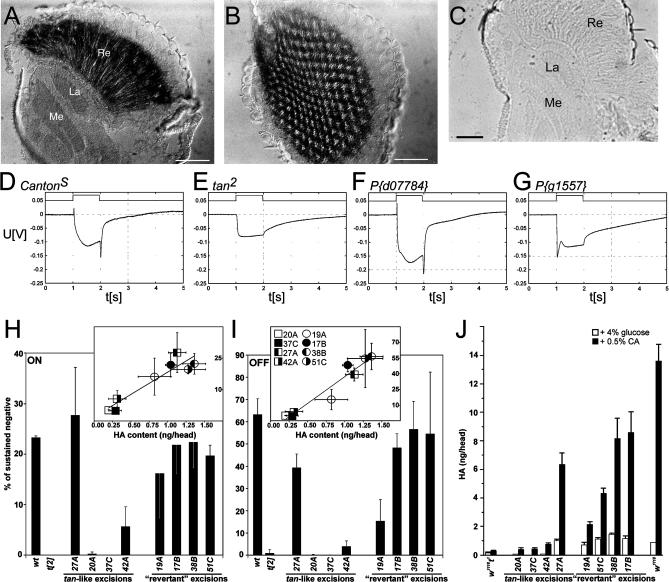
Tan Expression and Function in the Eye and Optic Lobes(A) RNA in situ hybridization with an antisense tan cDNA probe to wild-type adult head sections. Horizontal section cut through the eye and the optic lobes.(B) Sagittal section through the ommatidial array of the eye.(C) Control sense probe does not show significant staining (horizontal section).(D–G) ERG phenotypes of wild-type flies (D) and tan mutants (E–G). (D) CantonS (wild-type) ERG showing normal “on” and “off” transients. Upper trace in each recording indicates duration of light input stimulus (see Materials and Methods). (E) tan2 mutant showing complete absence of “on” and “off” transients. (F) P{d07784} exhibits a normal “on” and “off” transient even though it has a tan-like pigmentation phenotype. (G) P{g1557} lacks “on” and “off” transients.(H and I) Normalized “on” (H) and “off” (I) transients for wild-type, tan2 (t[2]), tan-like P excision lines, and “revertant” P excision lines (see text) expressed as a percentage of the respective sustained negative potential. Insets: Correlation between head histamine content and the normalized magnitude of ERG ‘on’ and ‘off’ transients (see text). Error bars: ± 1 standard error in both dimensions.(J) Head histamine contents for tan-like and revertant P excision lines (see text), relative to control w1118 and tan1w1118 flies. Head histamine increased in all flies that drank 0.5% carcinine in 4% glucose (black bars), relative to controls that drank only 4% glucose (open bars). Revertant and tan-like excision lines are each arranged in rank order. Note that excision line flies that drank only 4% glucose have histamine contents too small to show above the abscissa. Error bars represent ± 1 standard error.La, lamina; Me, medulla; Re, retina. Scale bars = 50 μm.